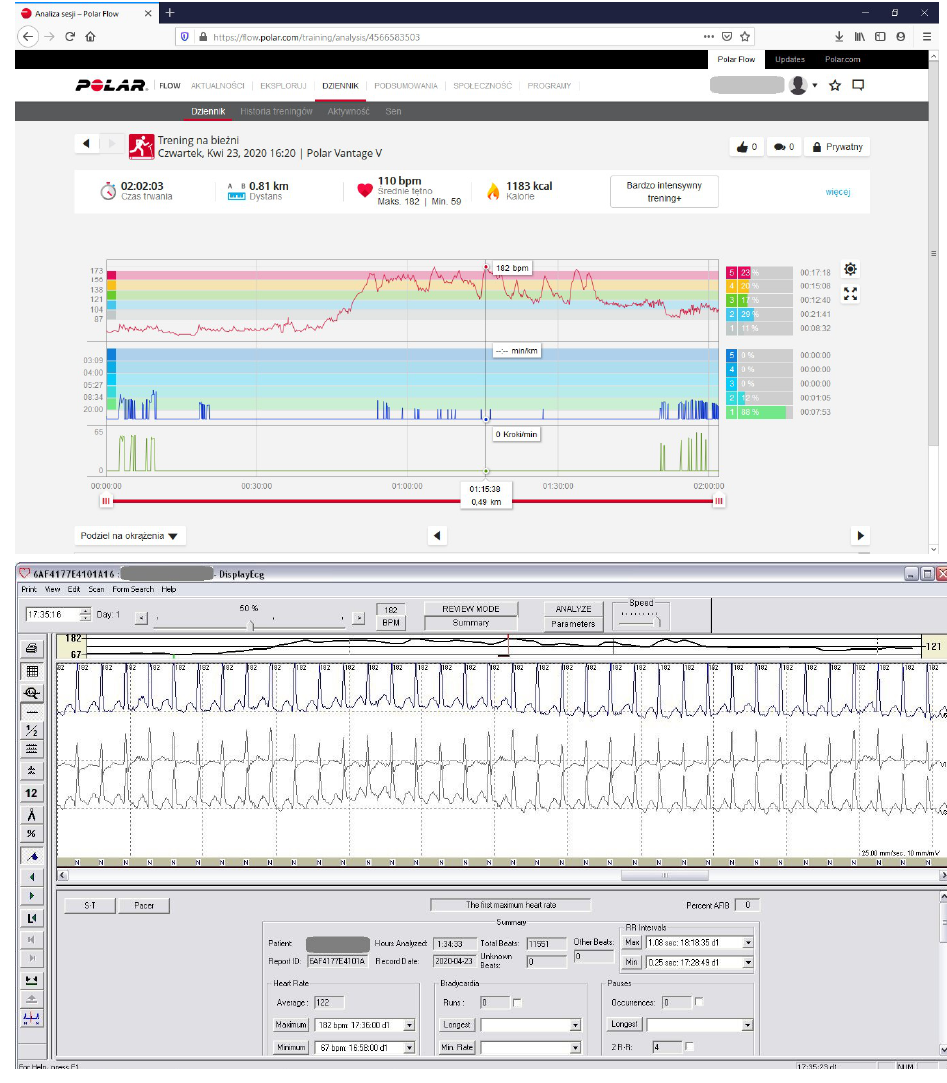
Figure 4. HRM control by comparing heart rate (HR) on HRM and at the same time in Holter ECG. The diagram with HRM indicates max. HR 182 / min. At the same time, the Holter ECG indicates a rhythm of 182 / min. The test was performed during a modified effort test on a treadmill. (number 8 in Table 4). Table 4. Tests for the correctness of the HRMs’ indications used by the athlete versus Holter ECG.